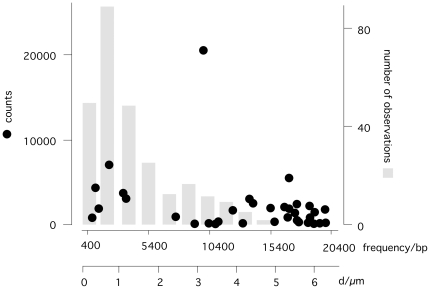
Histogram of the leading inverse Fourier-frequency (in bp) for all sequence motifs of length eight (round symbols).The most pronounced peaks occur at 9,935 bp, 2,138 bp, and 17,020 bp. For comparison we also illustrate the distribution (grey bars) of distances between individual fluorescence maxima from Fig. 1H. We assume that 1 kb DNA is in the extended form 0.323 µm long.